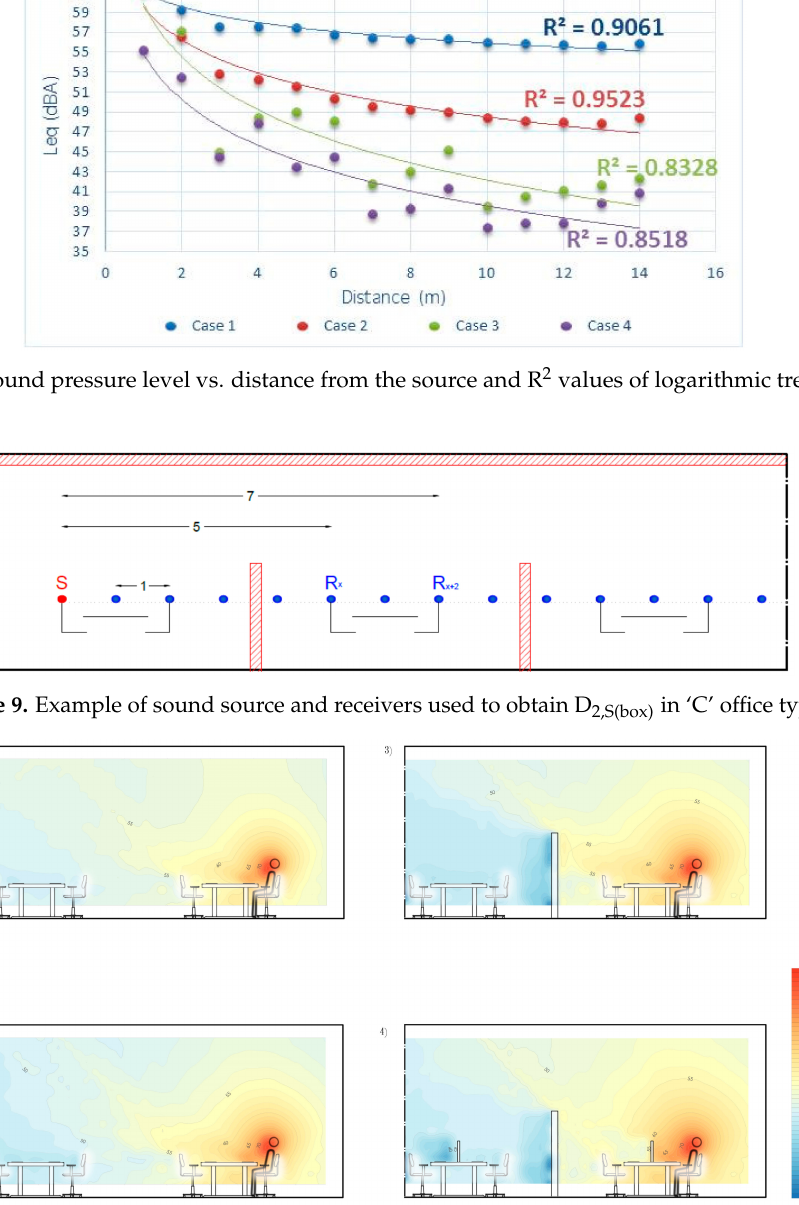
Figure 10. Sound propagation map in the four conditions studied in office type